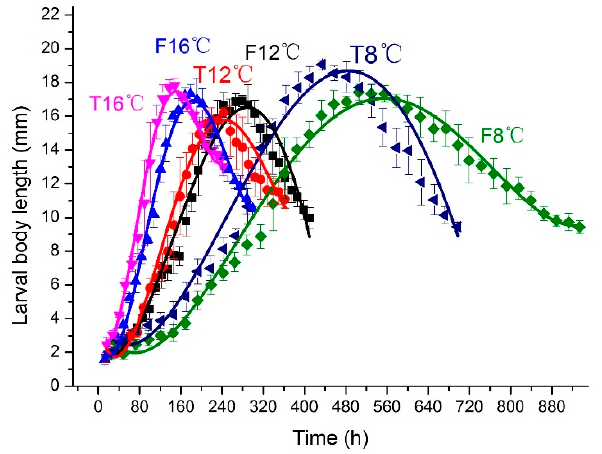
Figure 2. Changes in A. grahami larval body length (mm) over time (h) at different constant temperatures and. fluctuating temperatures. The vertical bars represent the standard deviation. The curve represents the fitting of larval body length and time.